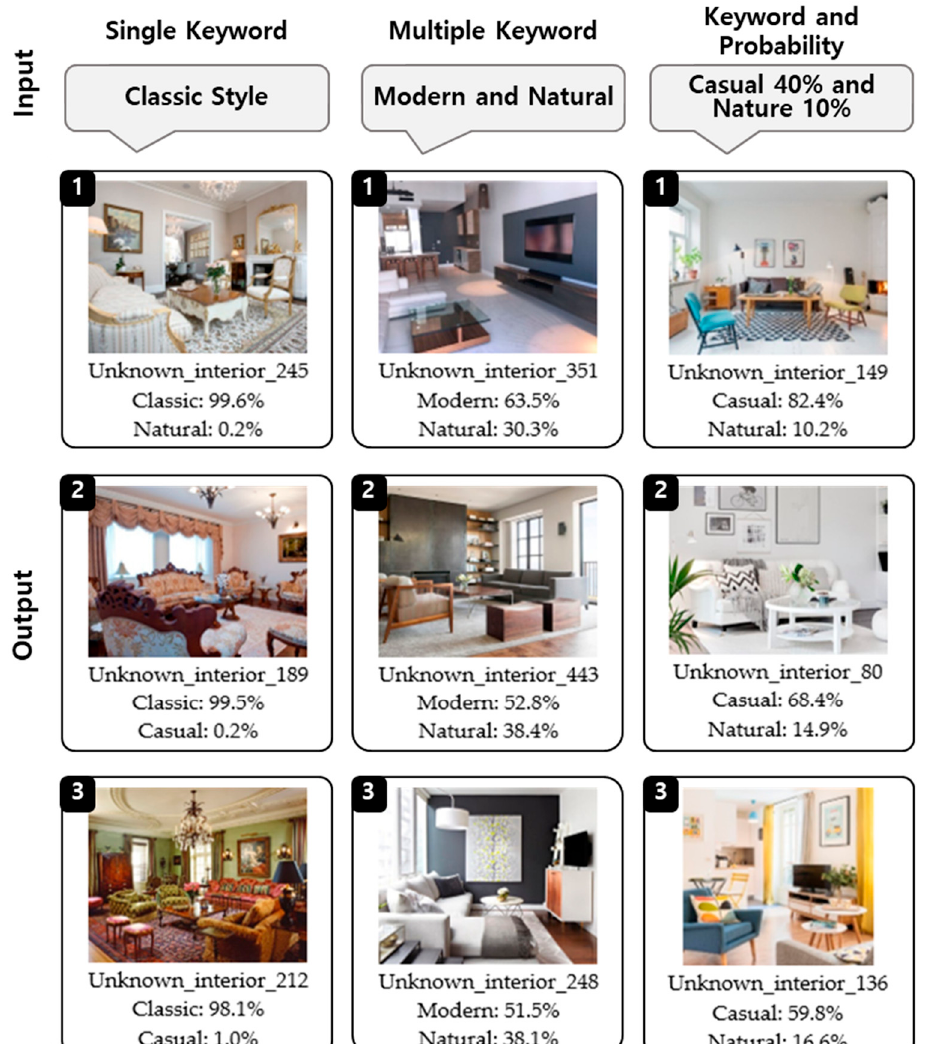
Figure 10. Examples of retrieval of a reference image with detected style information from the database.